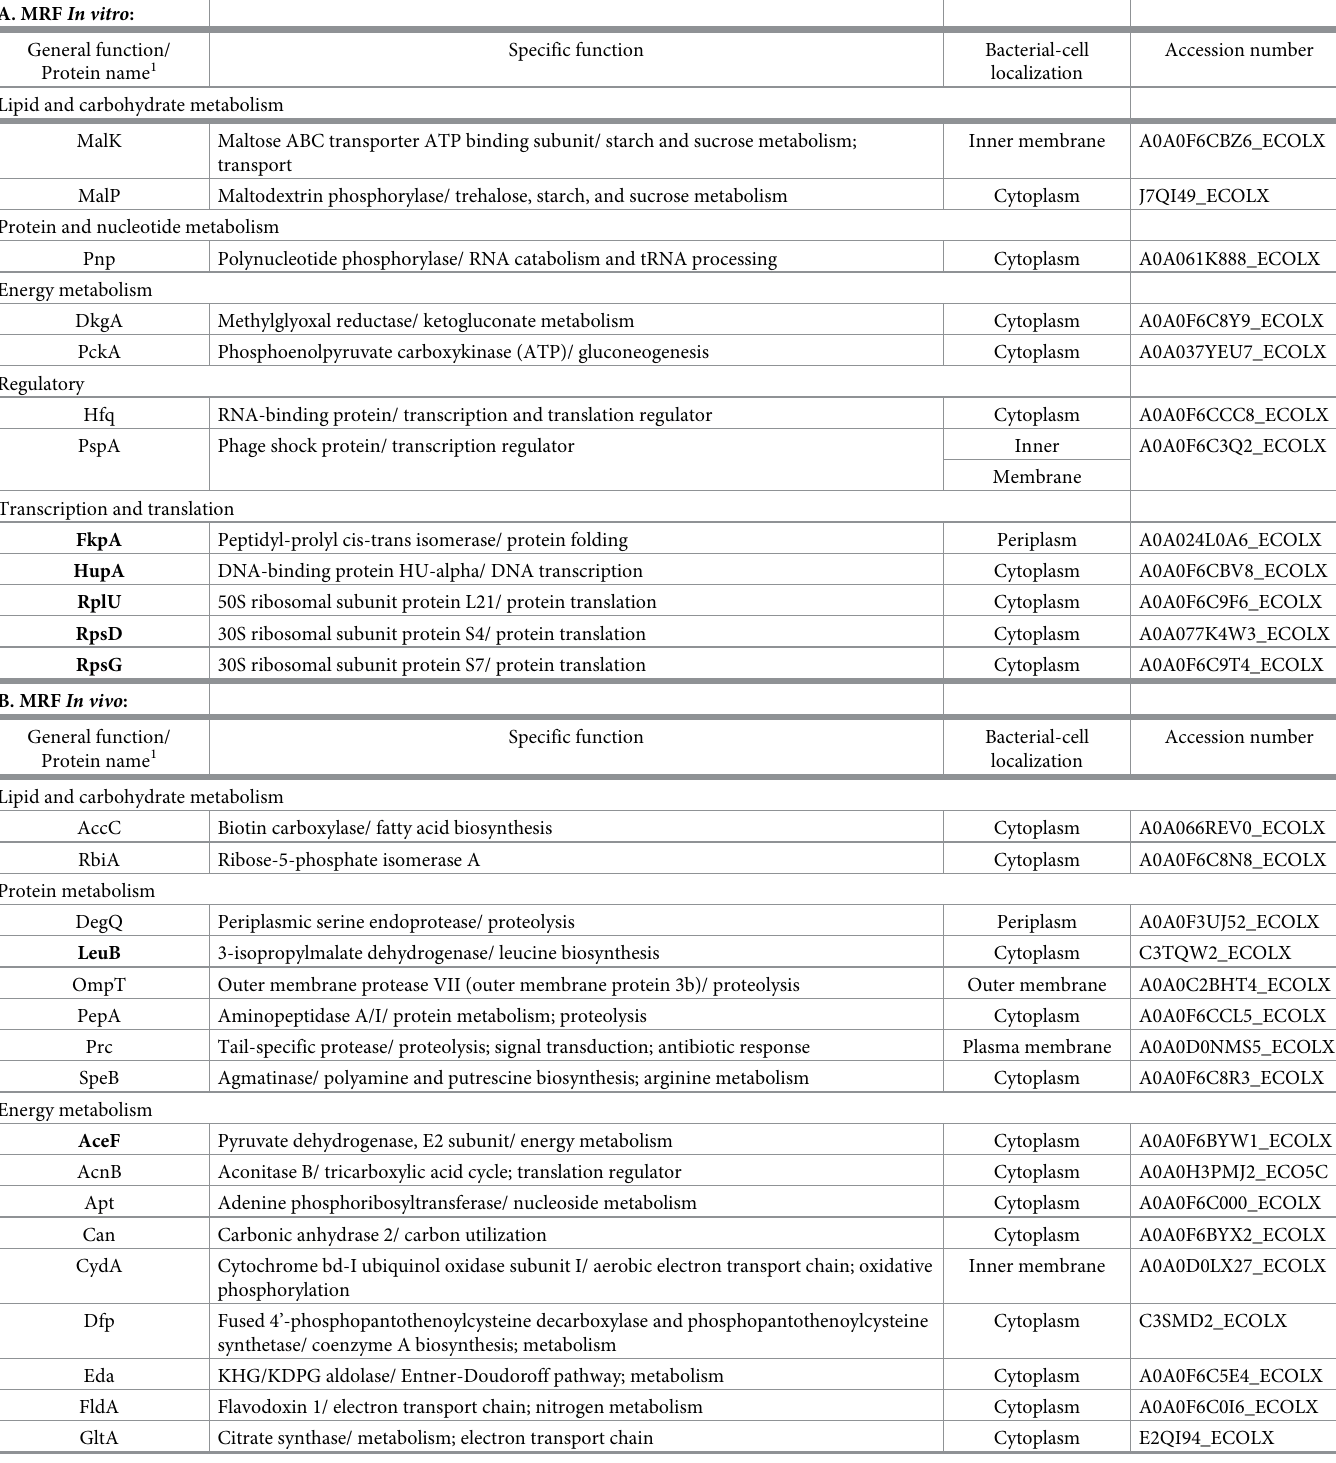
Table 1. O157 proteins up-regulated, under the in vitro and in vivo growth conditions, in MRF and LRF, as determined by reference-based iTRAQ analysis #1. (Ref- erence:86–24 in vitro proteome). A. MRF In vitro